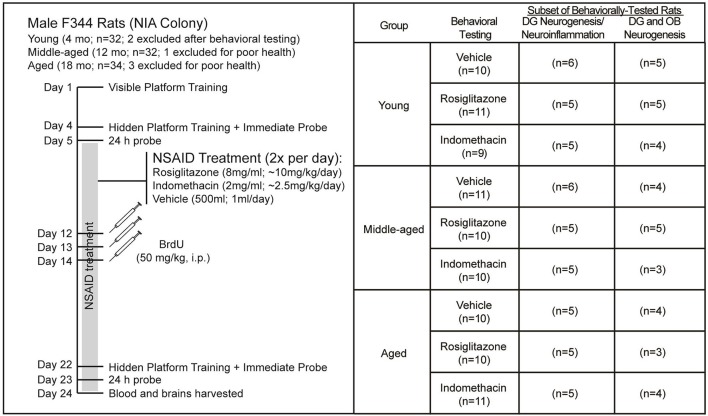
Experiment Design. Young (4 mo; n = 32), middle-aged (12 mo; n = 32), and aged (18 mo; n = 34) male F344 rats were trained on 5 visible platform trial blocks followed 3 d later by 4 hidden platform trial blocks and then probe trials 15 min and 24 h later. After uniform assignment to drug treatment groups, rats were fed vehicle (500 μl), indomethacin (2.0 mg/ml) or rosiglitazone (8 mg/ml) 2x a day (12 h apart; BID) until the experiment endpoint. After a week of drug treatment, rats were injected daily over 3 d with BrdU (50 kg/kg) and after 18 d of NSAID treatment, the rats were trained to locate a novel hidden platform position in a 2nd water maze session and then given probe trials 15 min and 24 h later and killed 24 h after the final probe trial. Two young rats were excluded from the study after exhibiting excessive thigmotaxia in the 1st water maze session and 1 middle-aged rat and 3 aged rats were excluded from the study because of poor health. Final numbers included in each analysis are shown. Note that subependymal and hippocampal neurogenesis was quantified in the same rats, but that a smaller subset is reported for subependymal zone neurogenesis because some sections were lost.